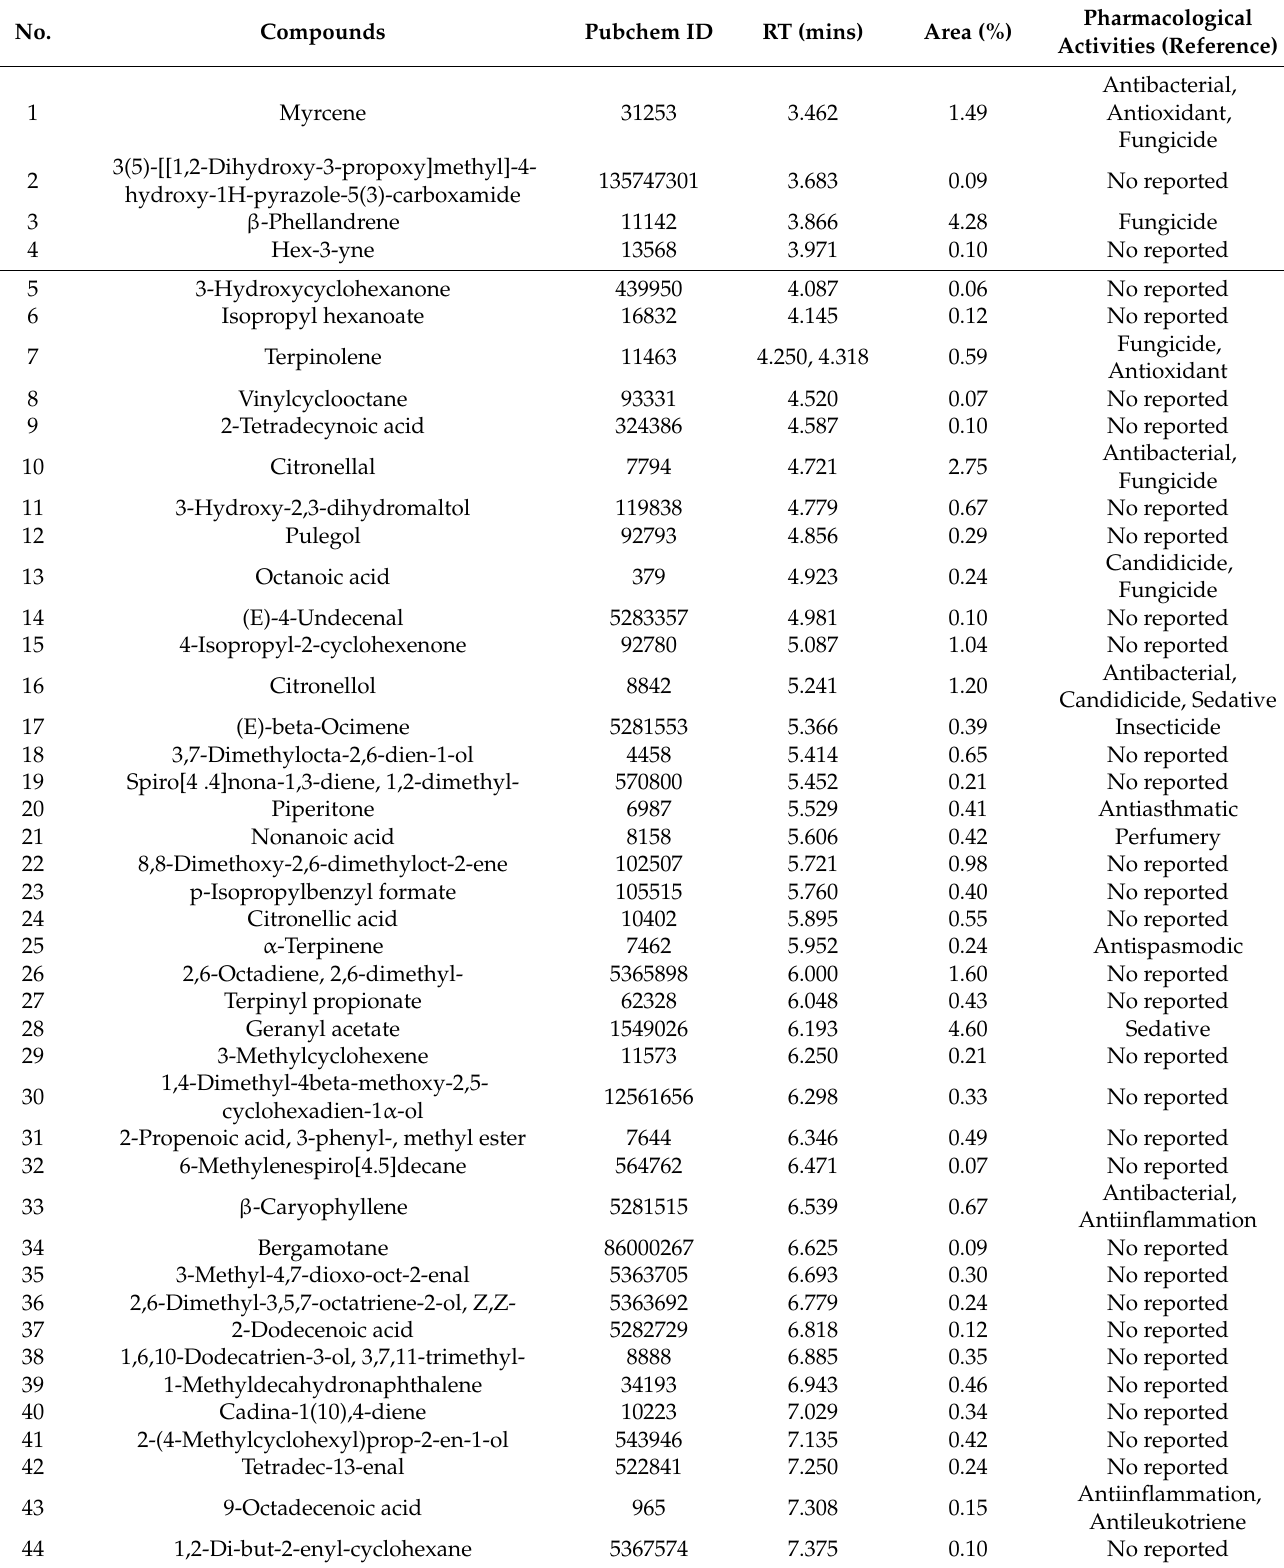
Table 1. A list of 85 chemical compounds identified from ZPFs via GC-MS and profiling of bioactivities.